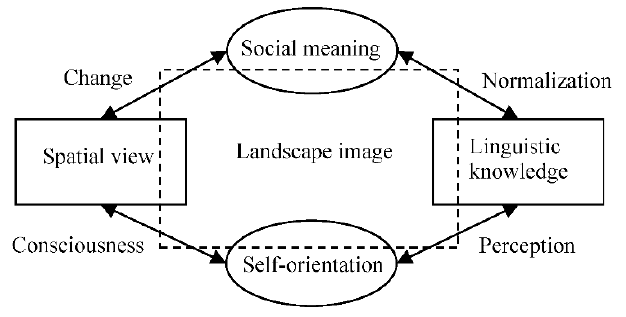
Figure 2. Diagram of a landscape image.